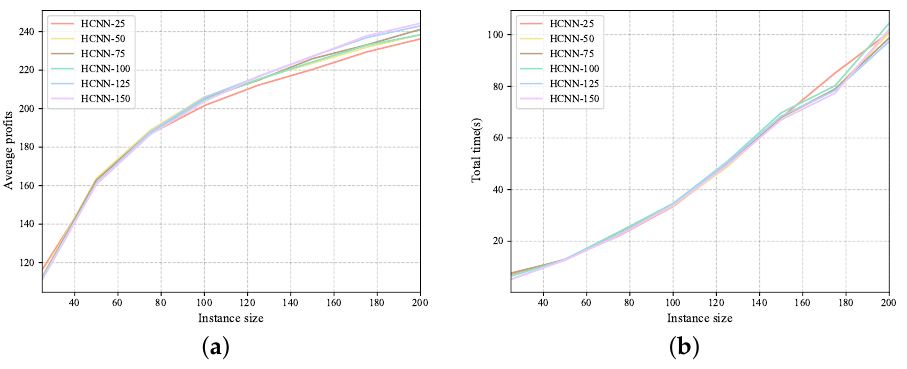
Figure 8. Performance of HCNN at different sizes. ( a ) Average profits for HCNN at different sizes. ( b ) Total time for HCNN at different sizes.